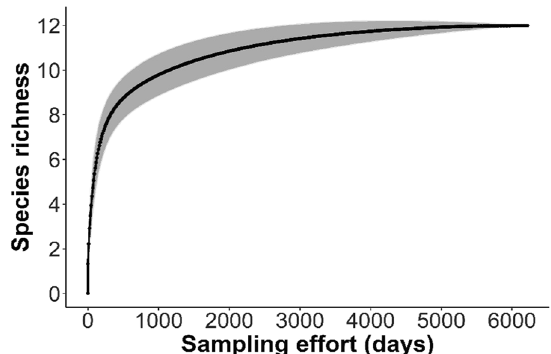
Fig. 2 Species richness as the number camera‑trapped species with 95% confidence intervals in function of sampling effort measured as camera trap days for the community of large‑ and medium‑sized mammals in a mountain Chaco